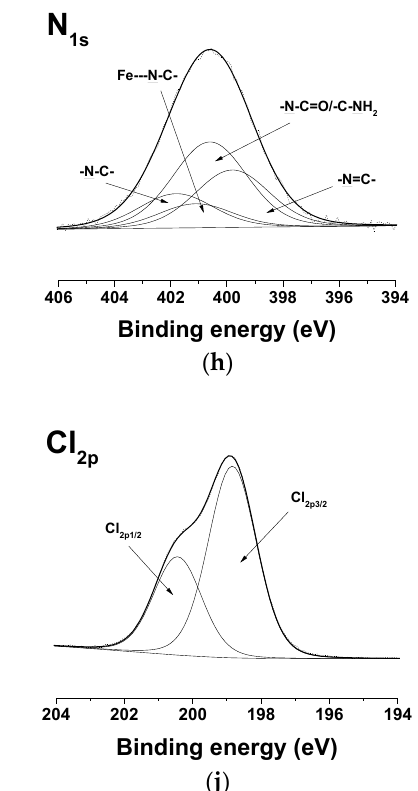
Figure 6. XPS peak fittings for Cu 2+ complex of Ch-8Q/PLA mat [C 1s ( a ), O 1s ( b ), N 1s ( c ), Cu2p 3/2 ( d ) and Cl2p ( e )] and Fe 3+ complex of Ch-8Q/PLA mat [C 1s ( f ), O 1s ( g ), N 1s ( h ), Fe2p 3/2 ( i ) and Cl2p ( j )].